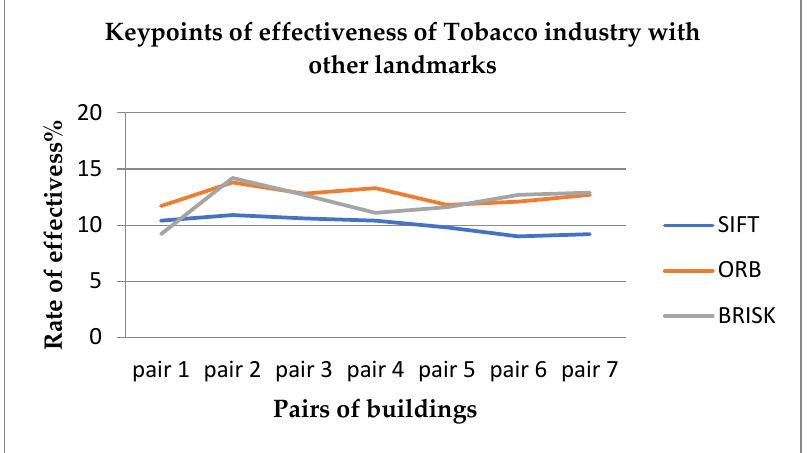
Figure 21. Effectiveness of keypoint matching in pairs of different building over time.